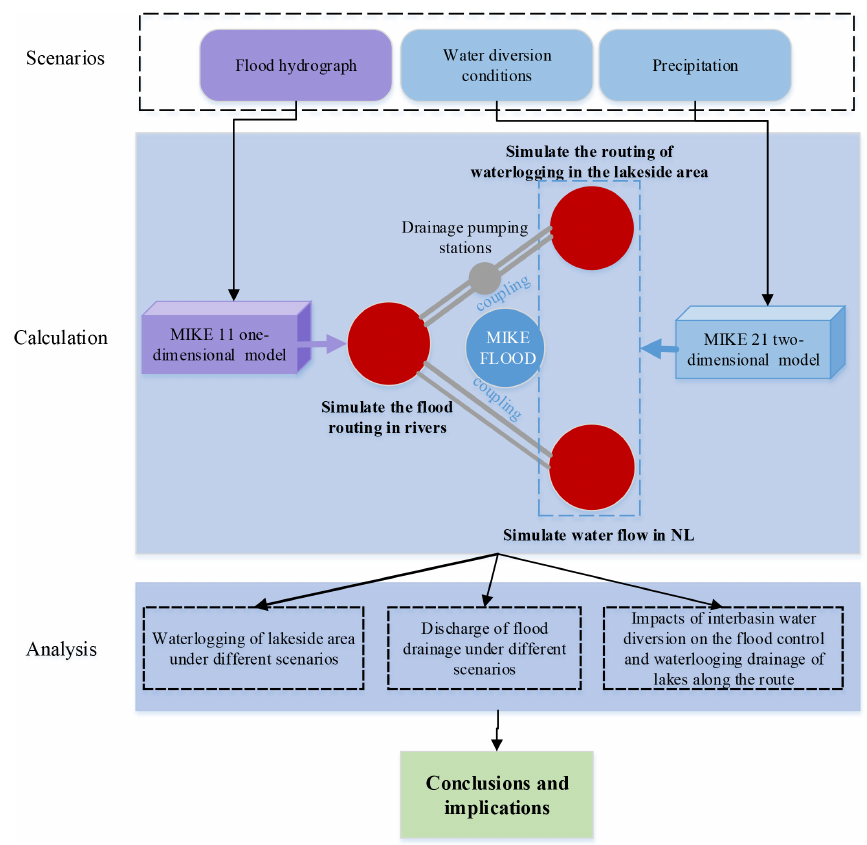
Figure 3. Research framework of the inter-basin water diversion influence on the flood control and waterlogging drainage of lakes along the